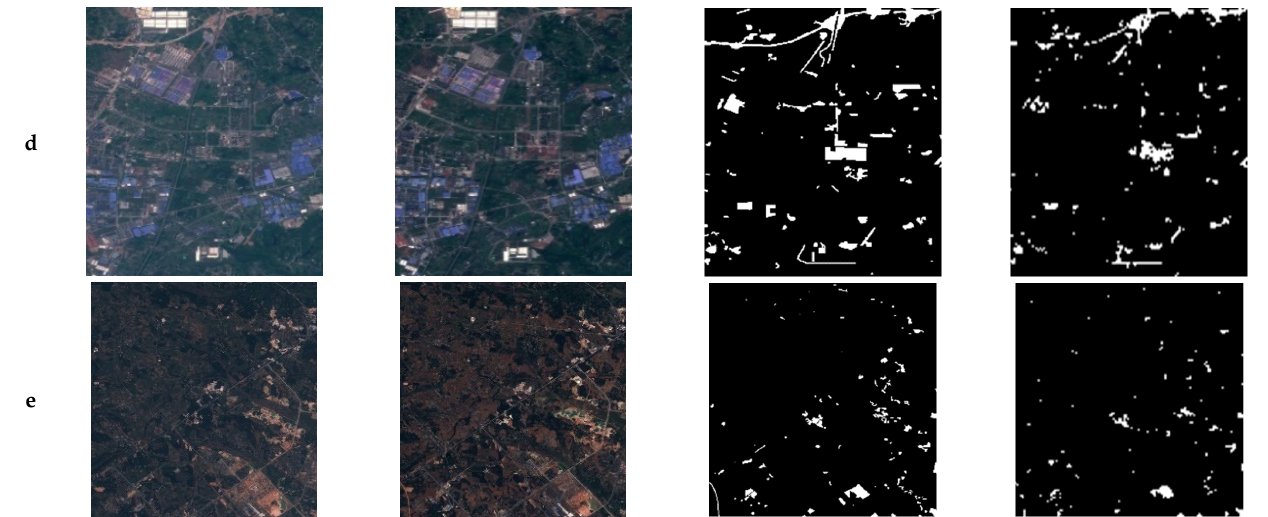
Figure 8. Results of the proposed method in the cities of Rio ( a ), Montpellier ( b ), Rennes ( c ), Chongqing ( d ), and Beihai ( e ) (from left to right: Time 1 image, Time 2 image, ground truth, and proposed method results).